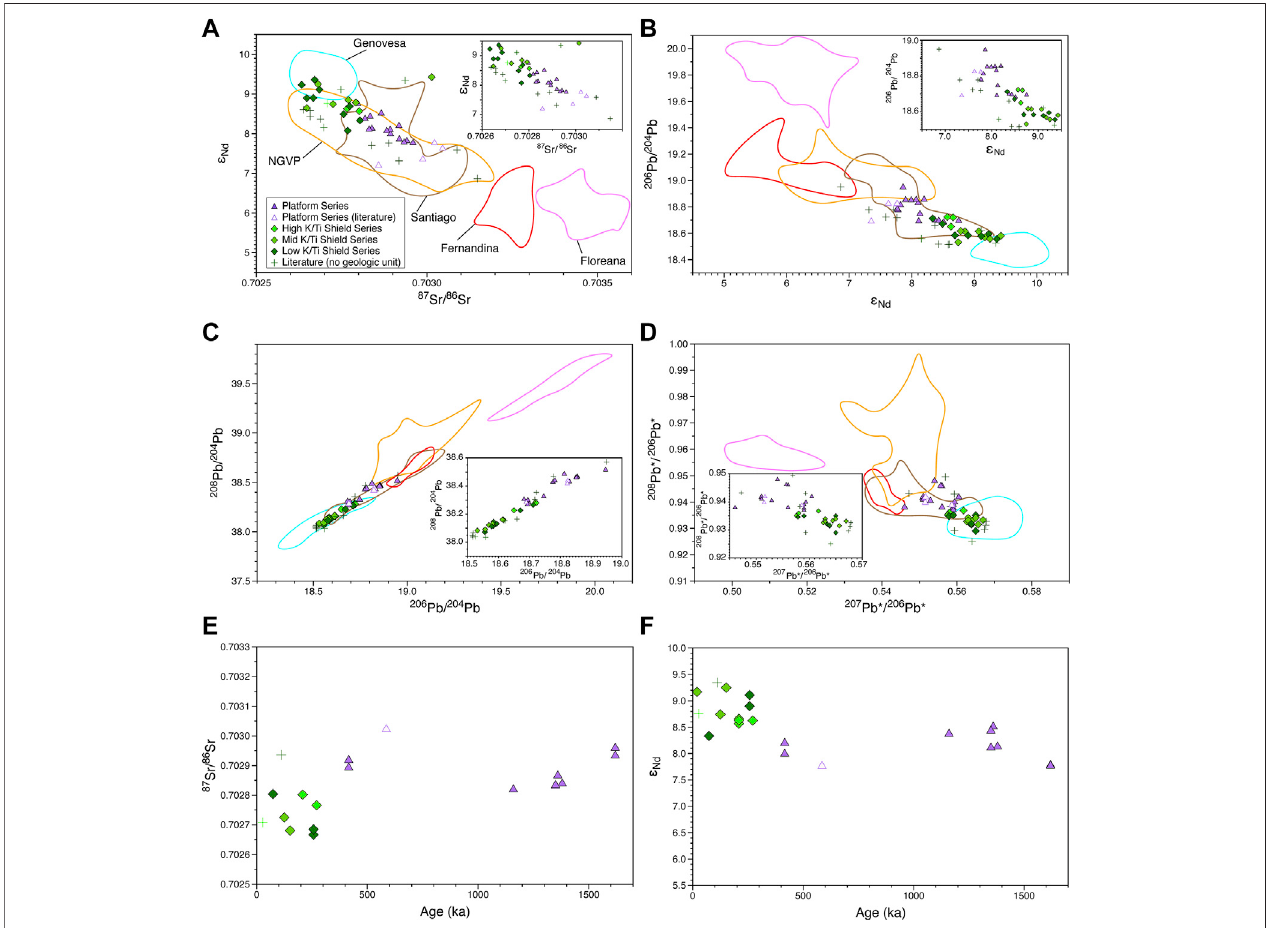
FIGURE 8 | Variations in radiogenic isotope ratios for Santa Cruz lavas. Fields are literature data. Red: Fernandina, blue: Genovesa, brown: Santiago, pink: Floreana, yellow: Northern Galápagos Volcanic Province (Bow and Geist, 1992; White et al., 1993; Harpp et al., 2002; Harpp et al., 2003; Saal et al., 2007; Gibson and Geist, 2010; Gibson et al., 2012; Harpp et al., 2014a; Harpp et al., 2014c). Symbols are larger than 1 σ analytical error. (A) 87 Sr/ 86 Sr versus ε Nd ; note that two Shield Series samples offset from the main array to higher 87 Sr/ 86 Sr values are likely contaminated by seawater and their compositions are not considered in further discussion; (B) ε Nd versus 206 Pb/ 204 Pb; (C) 206 Pb/ 204 Pb versus 208 Pb/ 204 Pb; (D) 207 Pb*/ 206 Pb* versus 208 Pb*/ 206 Pb*. Radiogenic lead calculation: 208 Pb*/ 206 Pb*